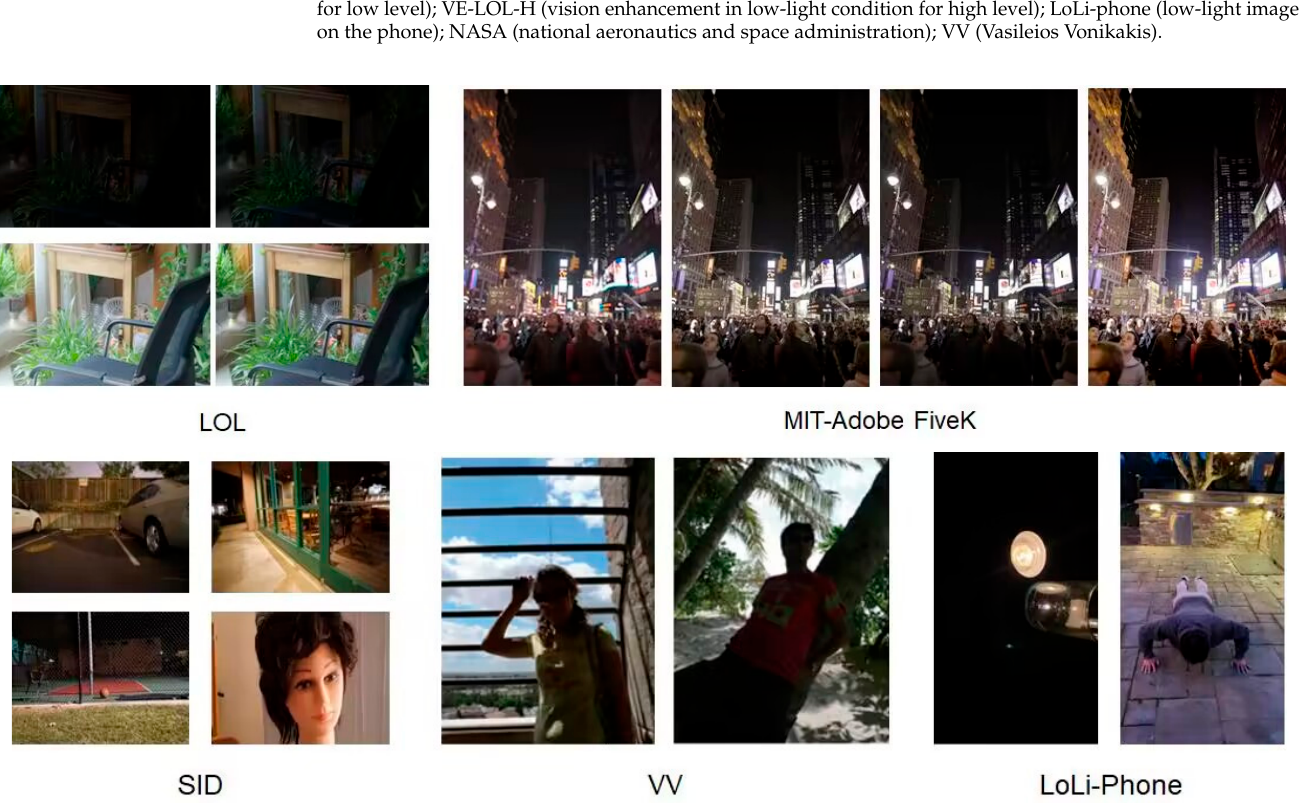
Figure 5. Flowchart of the RRDNet algorithm.